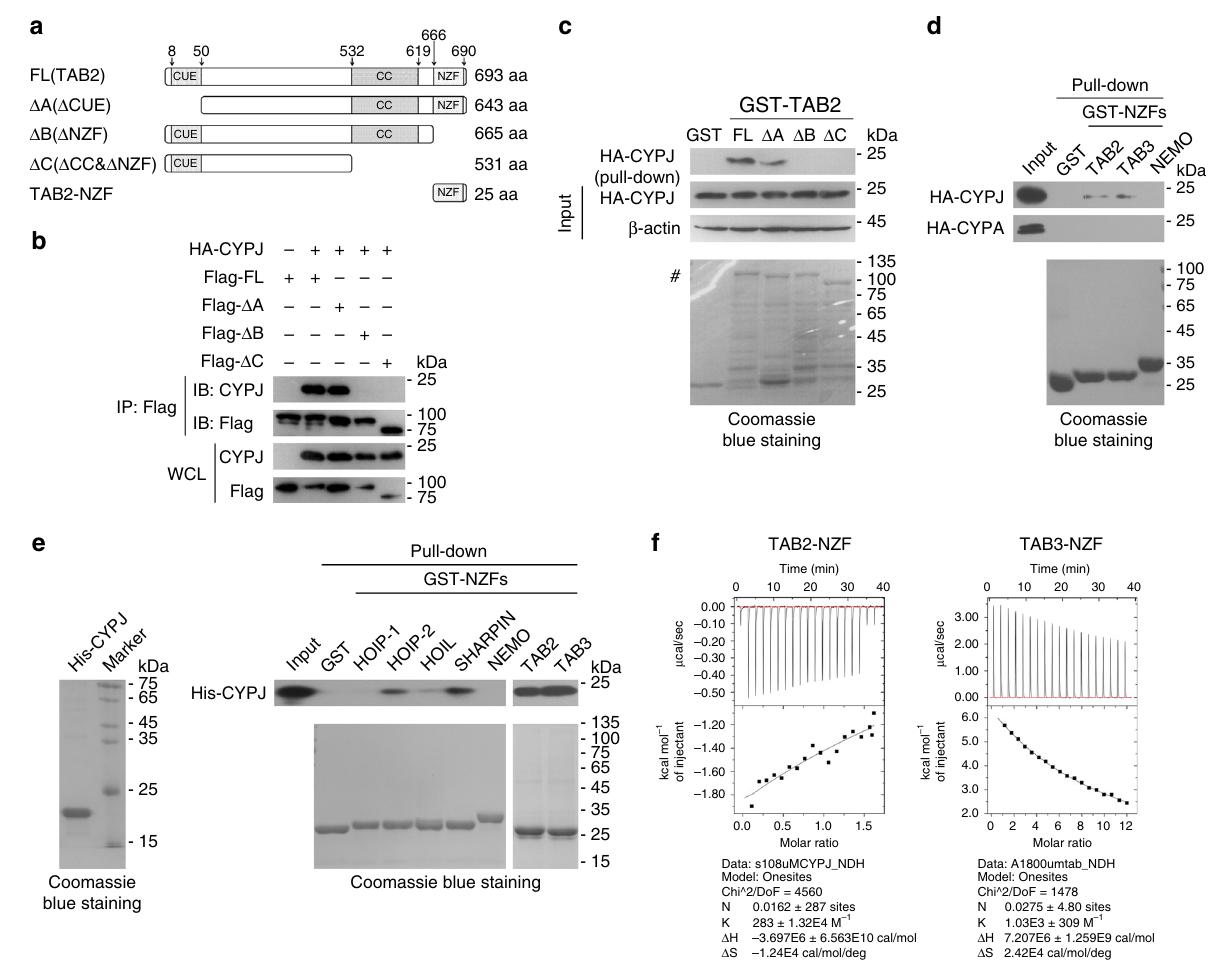
Fig. 4 CYPJ binds to the NZF domain of TAB2 and TAB3. a Schematic diagram of FL and truncation variants of TAB2. b HA-CYPJ and Flag-tagged TAB2 fragments were co-transfected into 293T cells for co-IP assays to detect their interaction. c GST pull-down assays were performed using E.coli -expressed GST and GST-TAB2 truncations and lysates of 293T cells transfected with HA-CYPJ. # indicates the bands of GST-fused full-length and truncated TAB2. d E.coli -expressed GST and GST-fused NZF domains of TAB2, TAB3, and NEMO were used in GST pull-down assays with lysates of 293T cells transfected with HA-CYPJ or HA-CYPA. e E.coli -expressed GST and GST-fused NZF domains of LUBAC members, as well as TAB2 and TAB3 were used in GST pull- down assays with E.coli -expressed His-CYPJ. f ITC assays were performed to detect the binding of in vitro synthesized NZF peptides derived from TAB2 or TAB3 to prokaryotically expressed